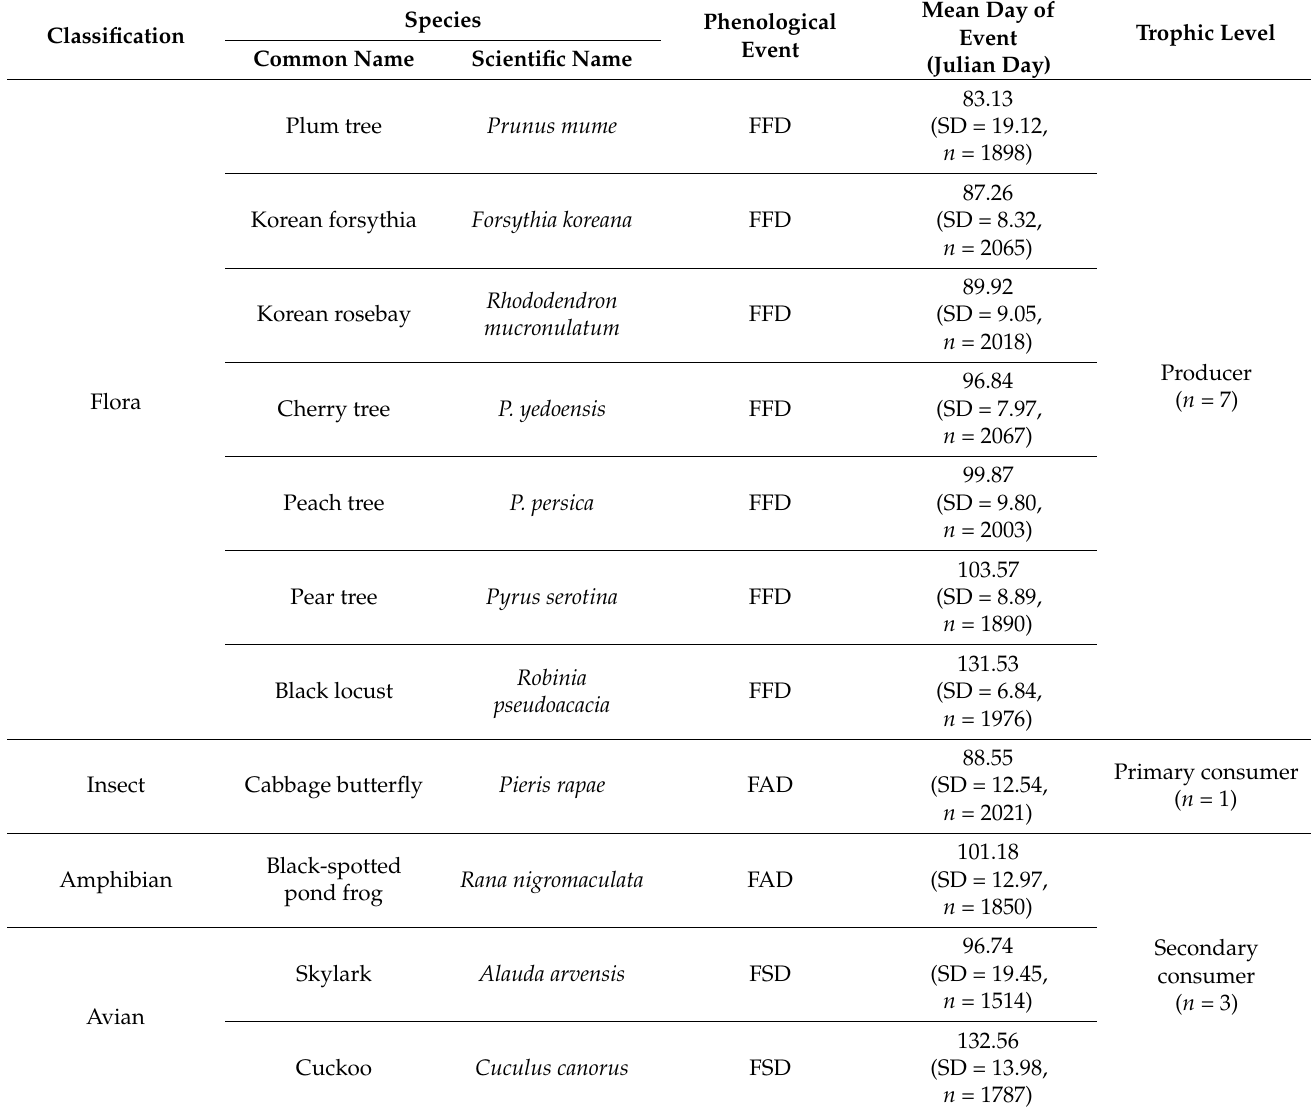
Table 1. List of species used in this study. Mean day of event refers to average dates of phenological event for each species during 40 years (1976~2015). And species are separated by trophic levels according to the status of organisms in the food chain in the ecosystem. (FFD = First Flowering Date, FAD = First Appearance Date, FSD = First Singing Date). Mean Day Species Phenological Classification Event